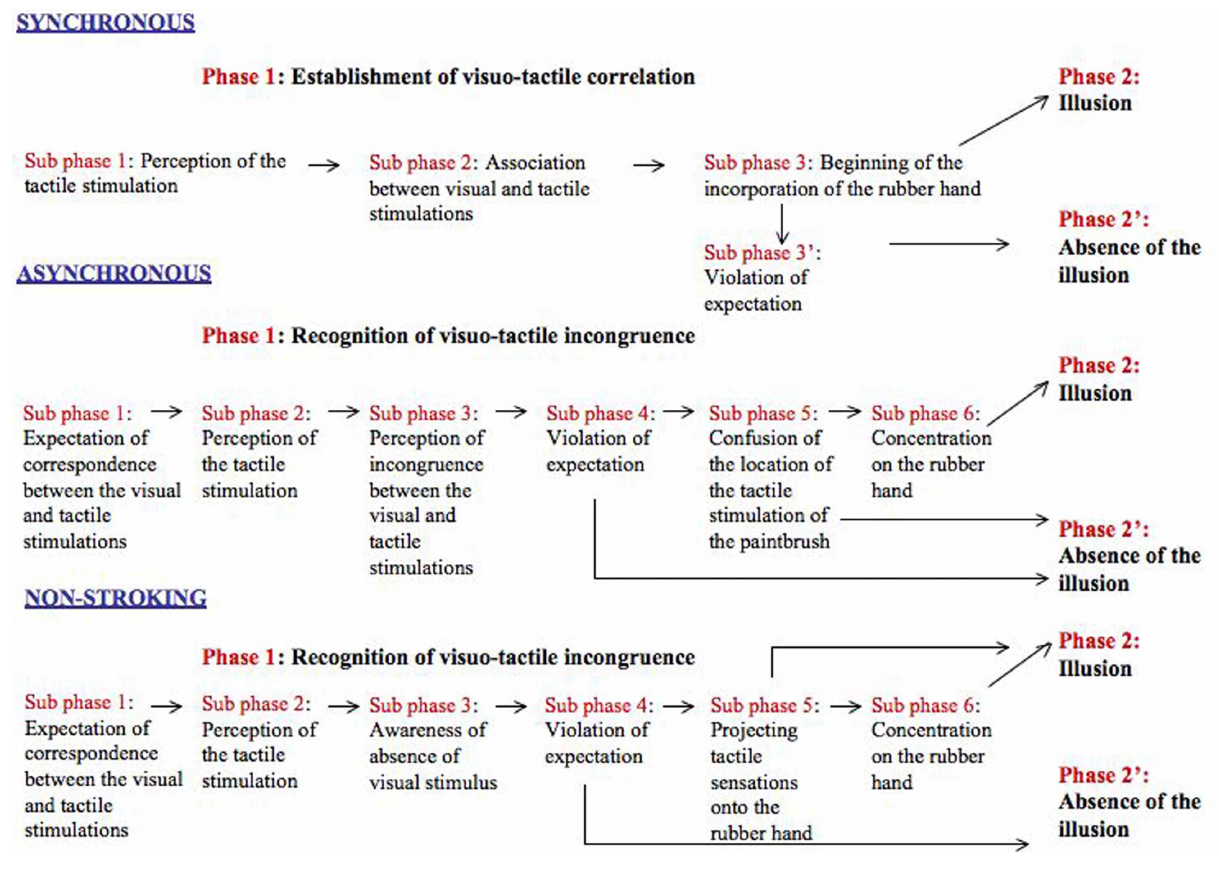
Frontiers in Human